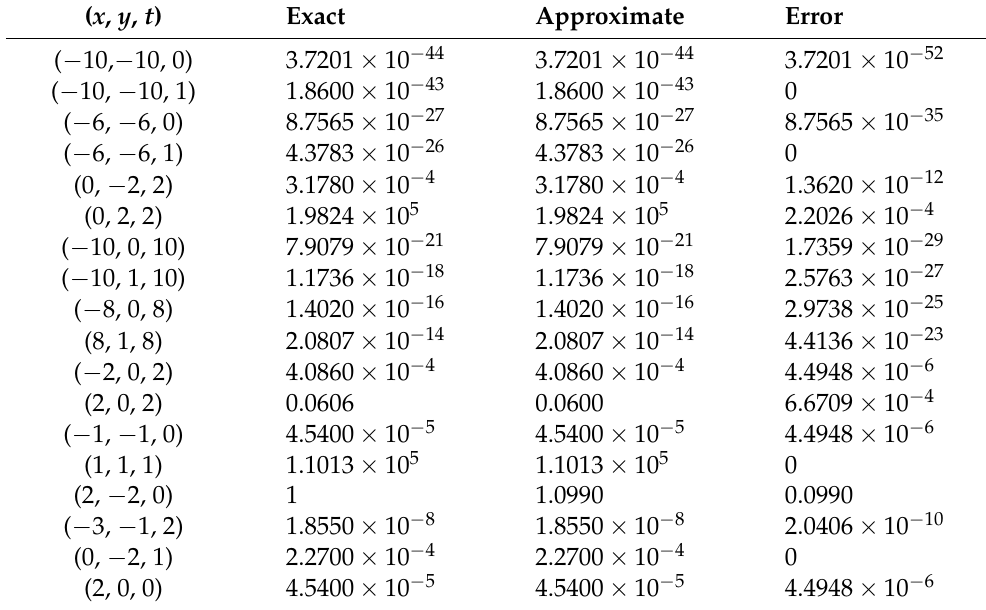
Table 2. Comparison table between the exact [15] and the approximate series solution Equation